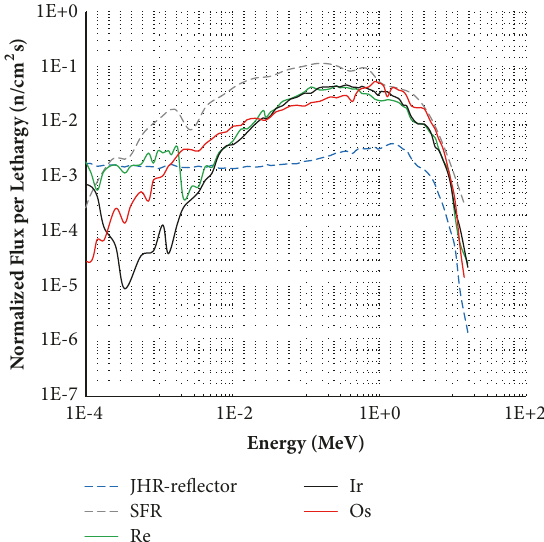
Figure 17: Effect of 3.4 cm thick neutron screens composed of Ir, Os, or Re on the JHR reflector neutron spectrum.